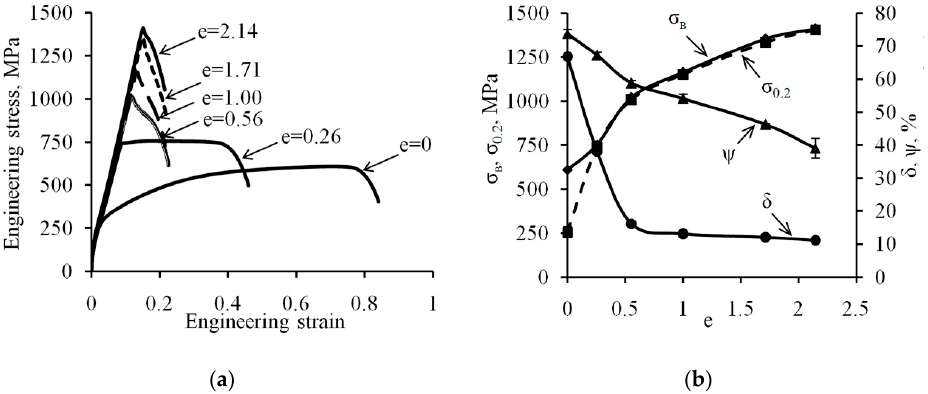
Figure 6. Results of tensile testing of the 321 MASS: ( a ) Stress-strain curves; ( b ) Relation of mechanical properties to the true strain value.